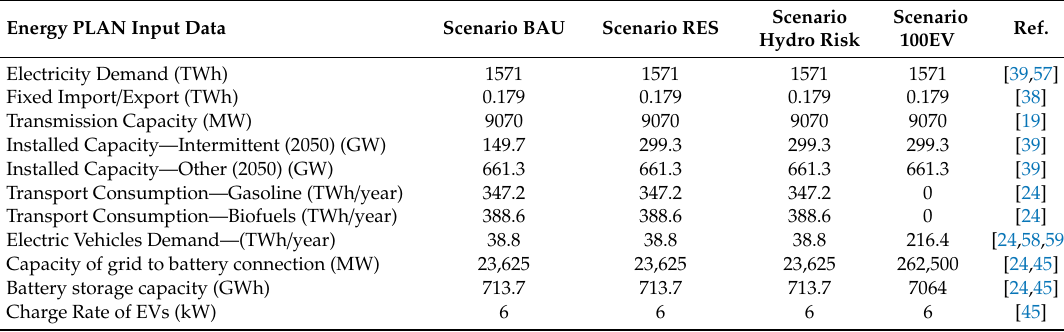
Table A1. Technical assumptions for each scenario.